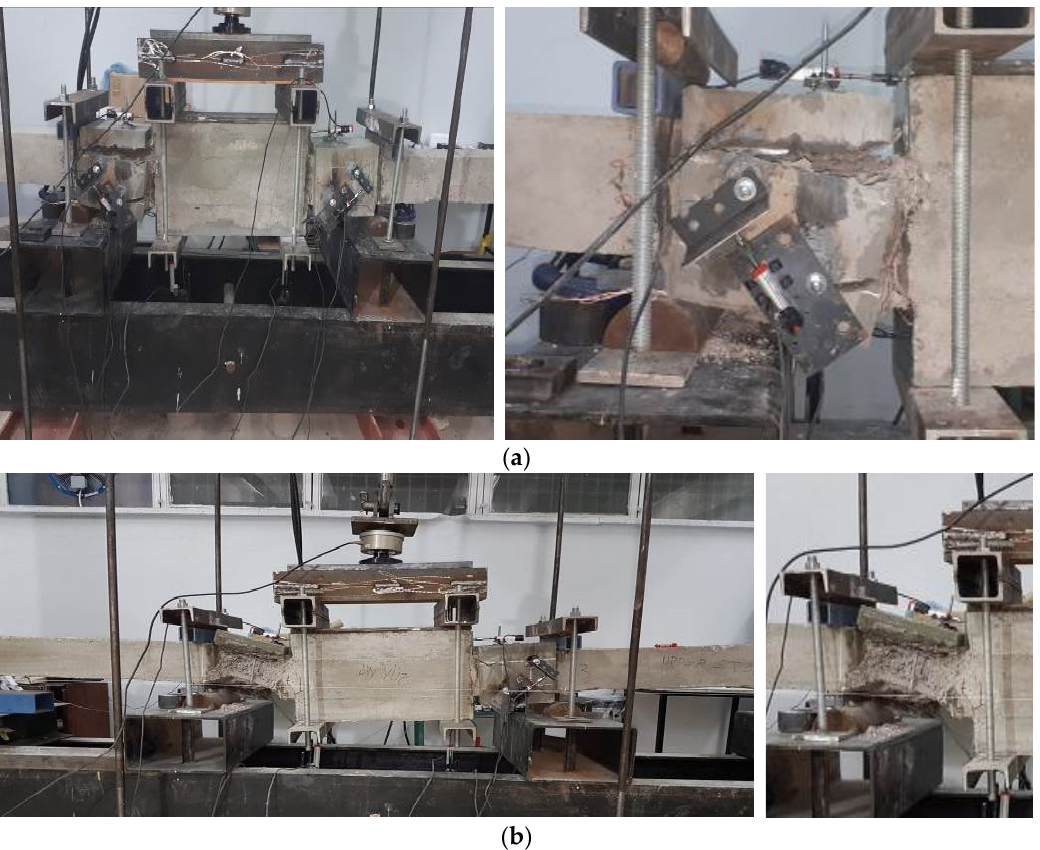
Figure 15. Damage of the retrofitted specimens at the end of the test . ( a ) DS-R ; ( b ) CCRS-R. Shear force–displacement diagrams for the retrofitted specimens are given in Figure 16a,b. As can been seen, brittle sudden failure was observed for both specimens. On the other hand, the shear capacity of both retrofitted specimens increased substantially. The area under the shear force–displacement curve also increased, which shows the increase in the energy dissipation capacity.